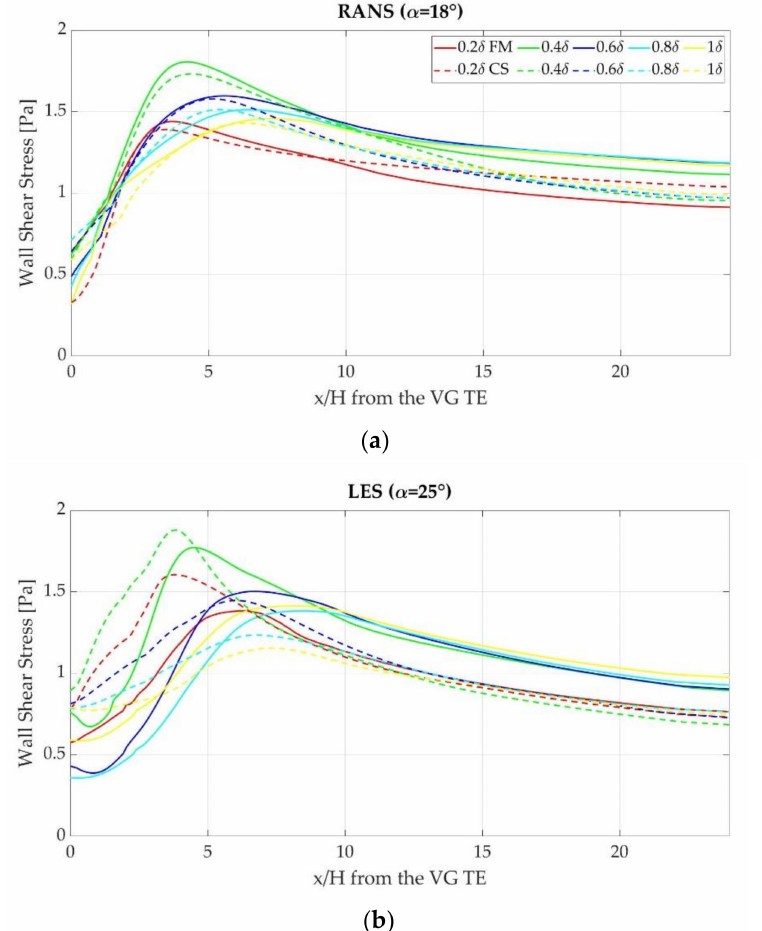
Figure 13. Wall shear stress on the wake behind the Trailing Edge (TE) of the VG. ( a ) RANS and ( b ) LES. With RANS, nearly equal locations of the maximums are obtained with both